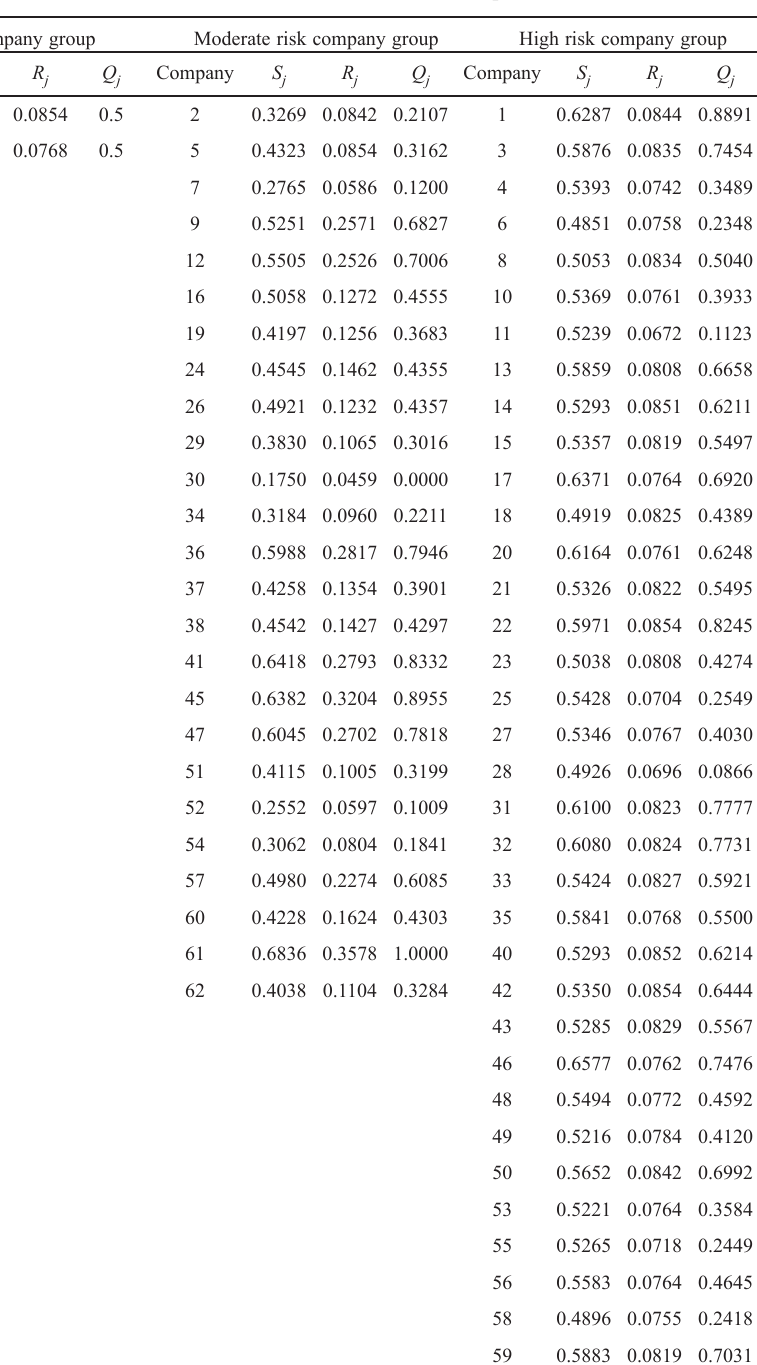
Table 6. The values of S , R and Q for all